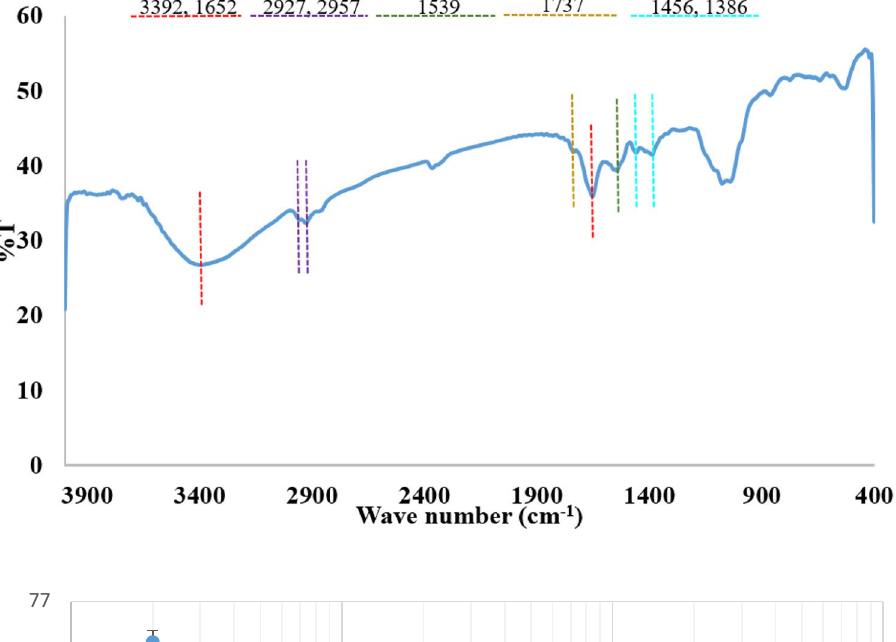
Fig. 3 Surface tension versus concentration semilog plot for biosurfactant produced by MJ01